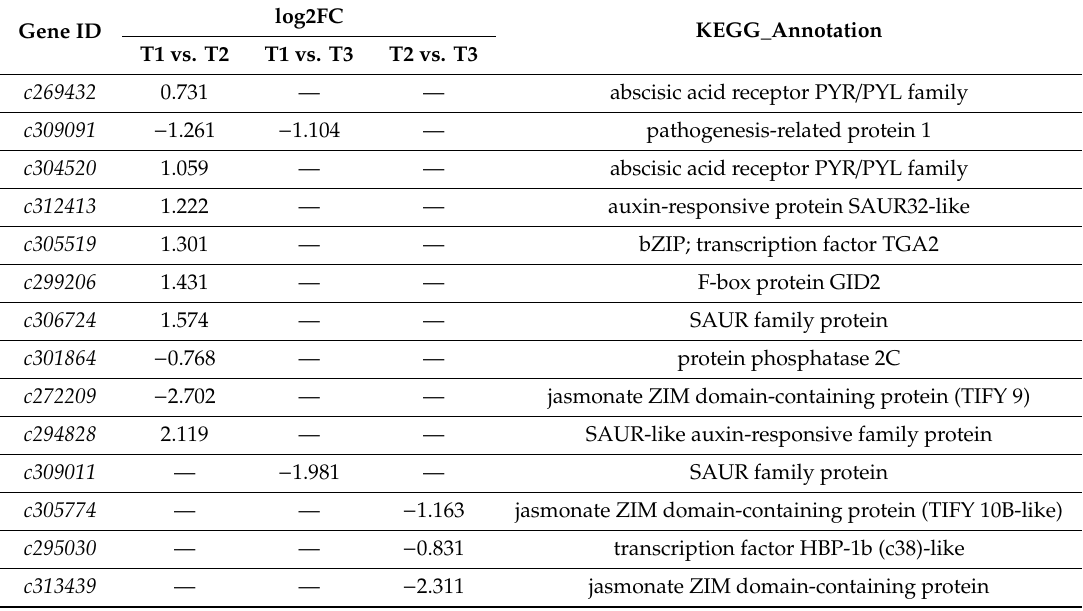
Table 2. Differentially regulated genes/transcription factors related to phytohormone regulation.